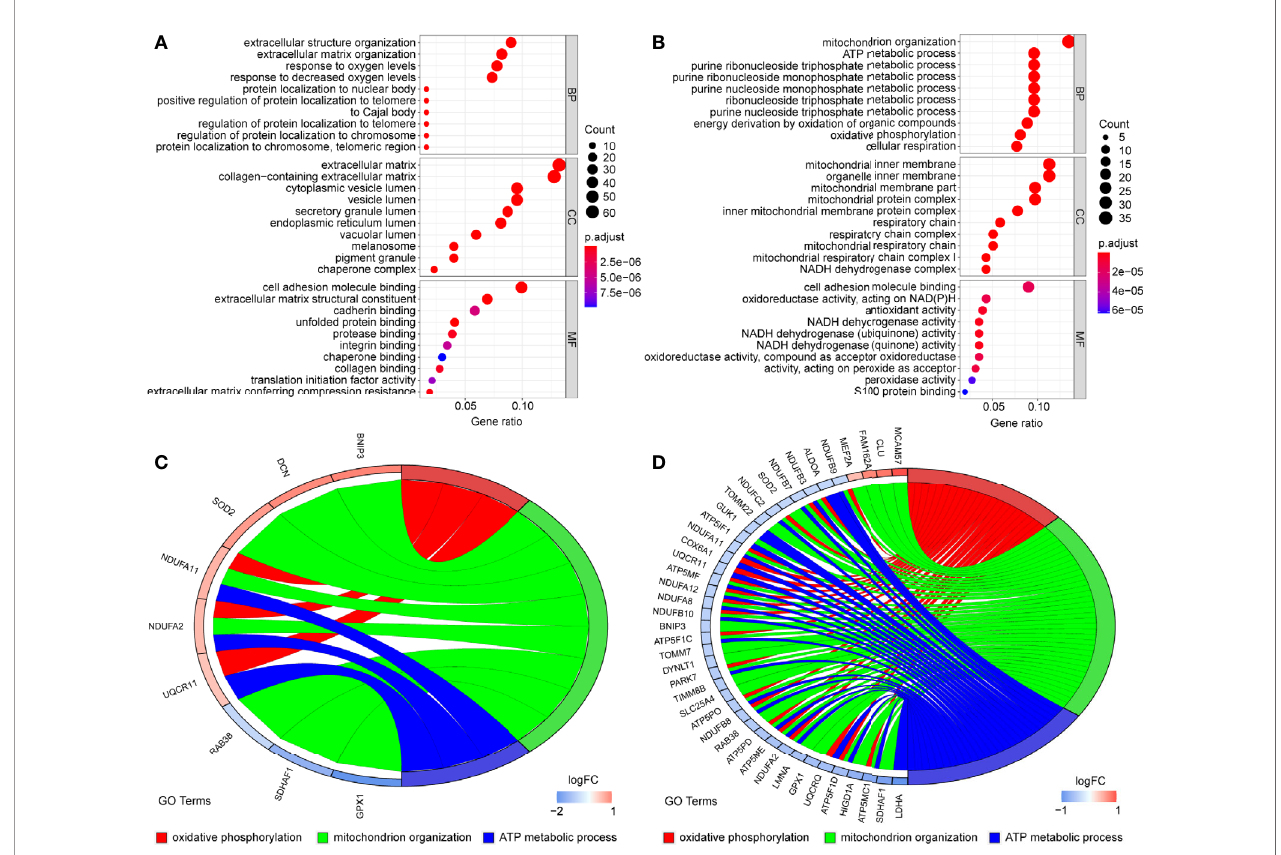
FIGURE 7 | Gene markers and functional analysis of each nucleus pulposus (NP) cell cluster. Bubble plots showing GO/pathway analysis results of marker genes in NP cell cluster 4 (A) and cluster 5 (B) . The chord plots reveal highly relevant functions and genes assigned to NP cell cluster 4 (C) and cluster 5 (D)